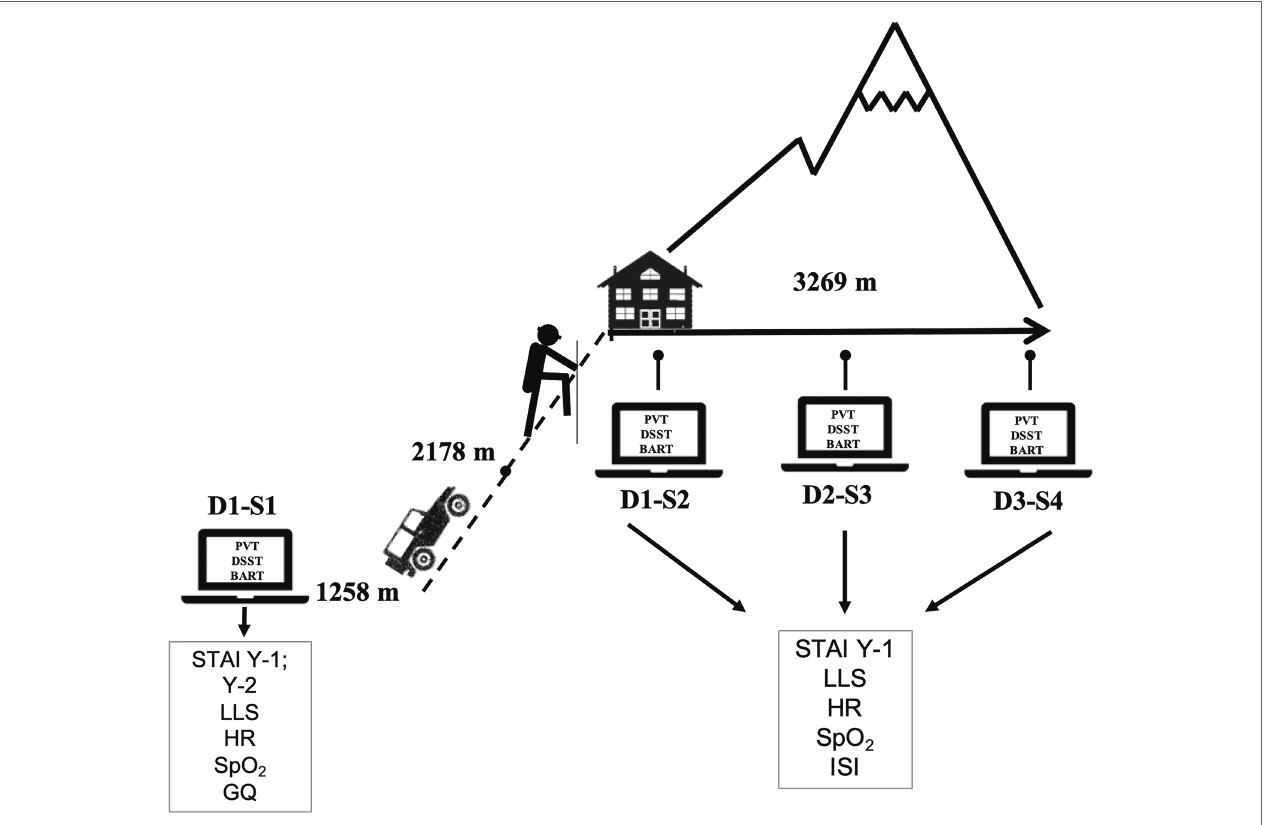
FIGURE 1 | Timeline of cognitive test, questionnaires administration, and physiological-parameter recording. BART, Balloon Analogue Risk Task; D, day; DSST, Digit Symbol Substitution Test; GQ, general questionnaire; HR, heart rate; ISI, Insomnia Severity Index; LLS, Lake Louise Score; PVT, Psychomotor Vigilance Test; S, session; SpO 2 , peripheral oxygen saturation; STAI, State and Trait Anxiety Inventory (Y1- state and Y2- trait